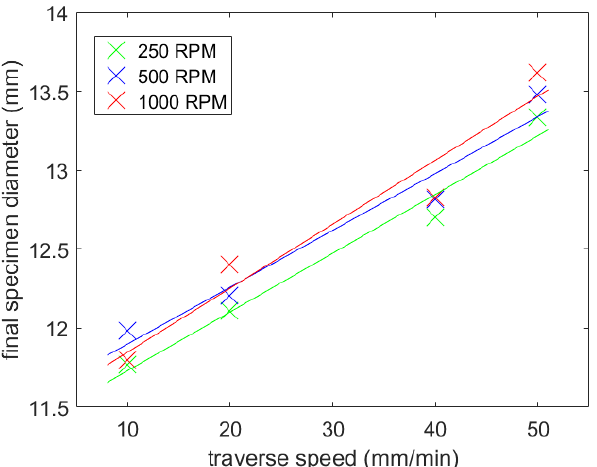
Figure 6. Influence of the traverse speed and the rotational speed on the final diameter (round rod).